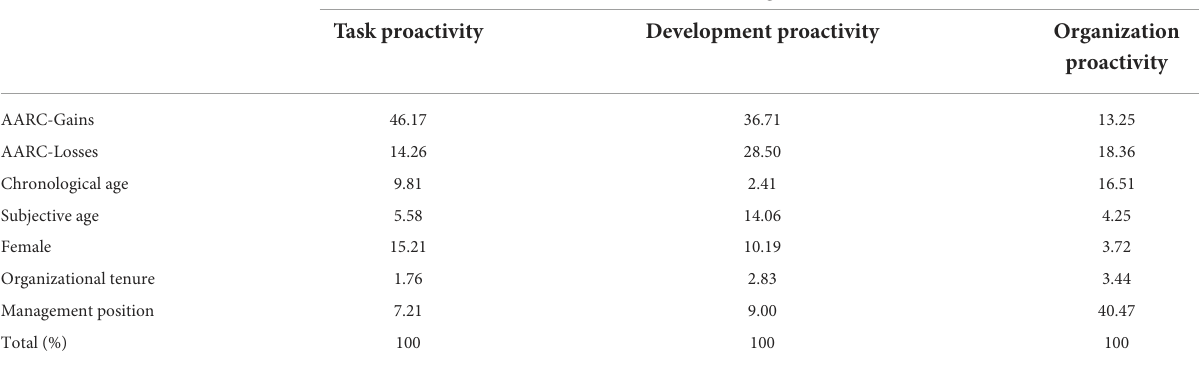
TABLE 5 Relative percentage contribution of predictors of types of proactivity.